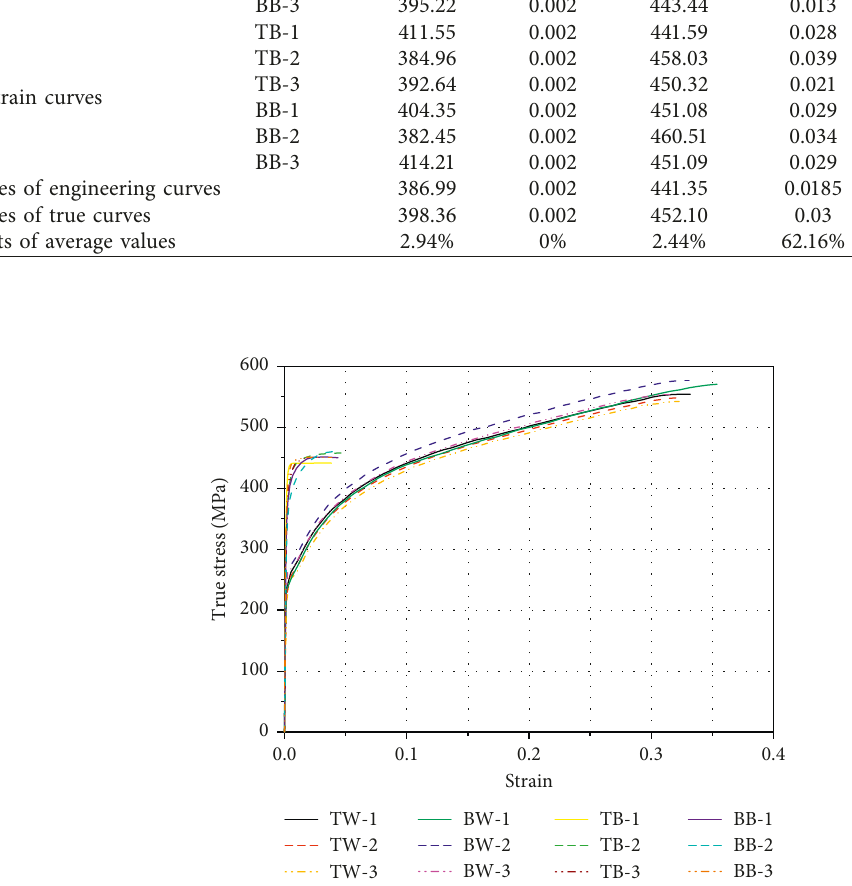
Figure 13: Comparison of true stress-strain curves of flat and corner